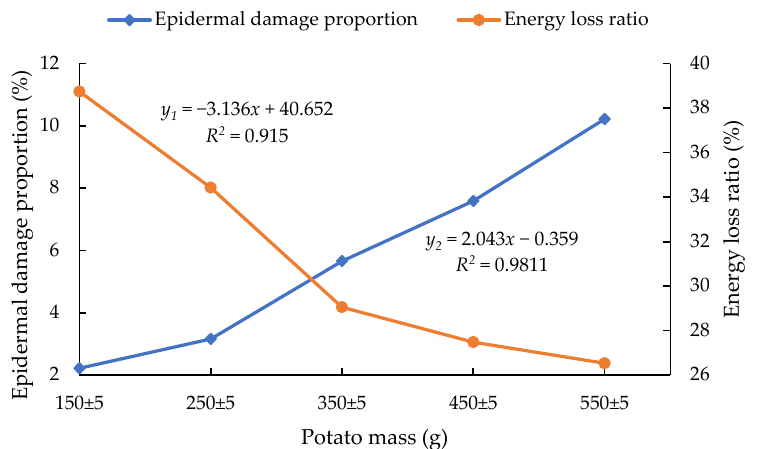
Figure 6. Relationship between potato mass and evaluation indexes. Note: The standard deviation range for the proportion of epidermal damage is 0.5 − 1, and the standard deviation range for the energy loss ratio is 3 − 7.